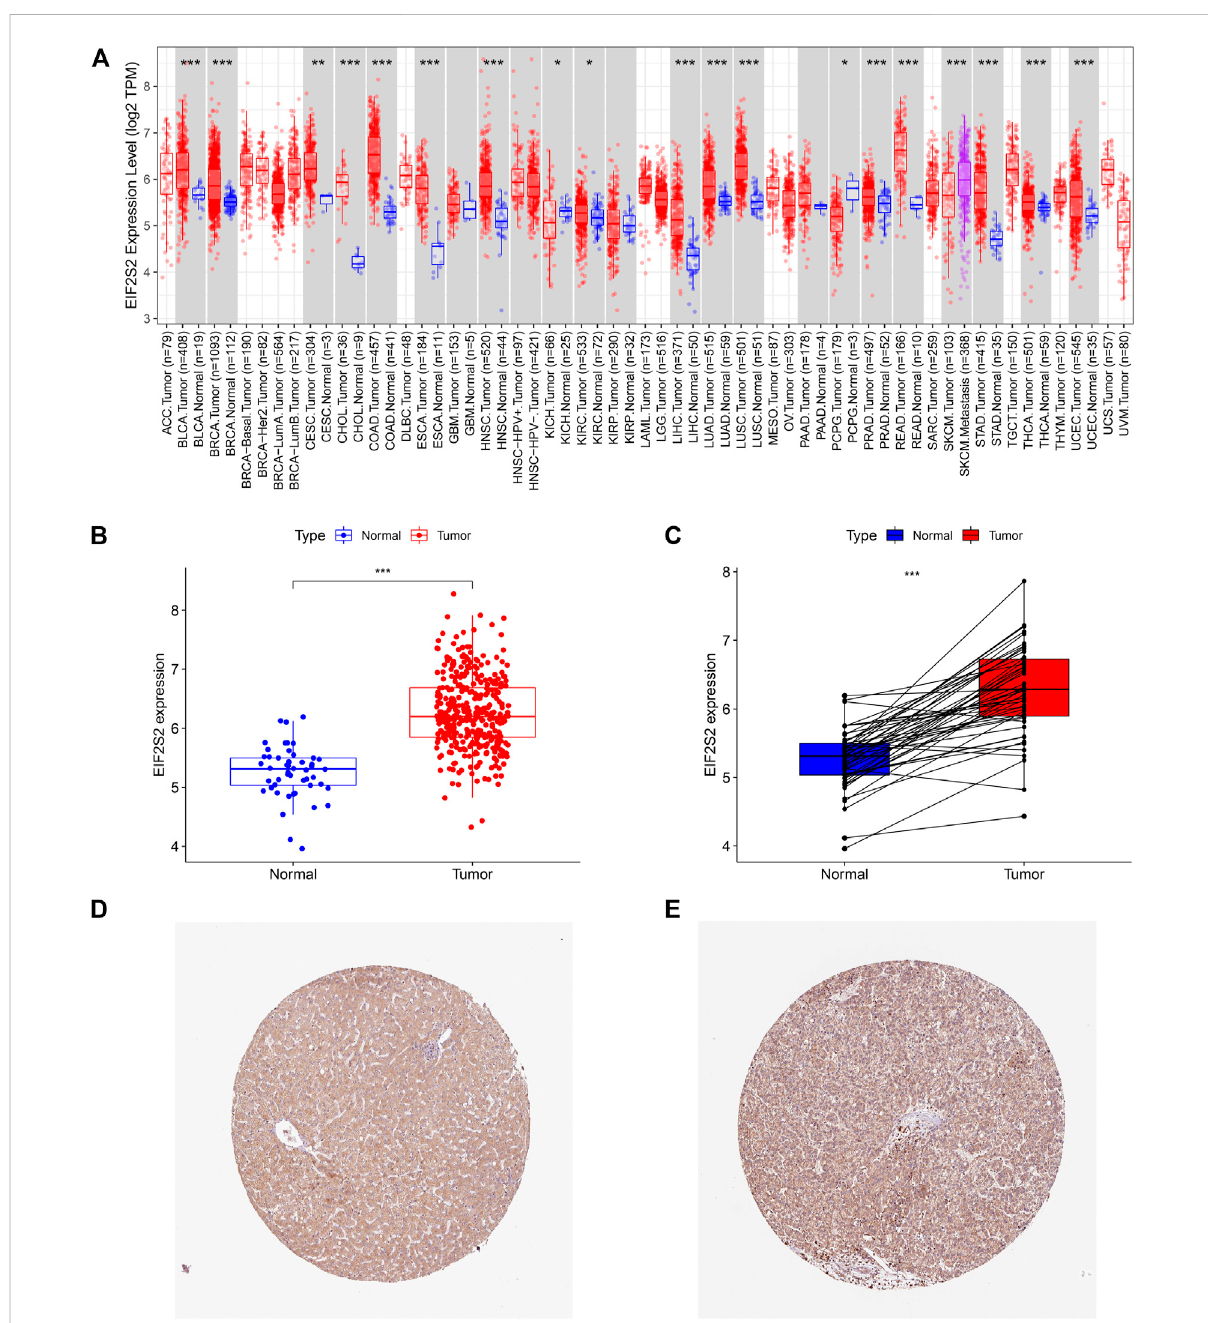
FIGURE 1 The expression of EIF2S2 in HCC. (A) EIF2S2 expression levels in different human tumor types according to TIMER 2.0 database. (B) EIF2S2 expression was compared in tumor tissue and control tissue samples in the TCGA database. (C) EIF2S2 expression levels were compared for pairedtumorandcontroltissuefromtheTCGAdatabase. (D,E) RepresentativeimmunohistochemicalimagesofEIF2S2proteinexpressioninnormal and hepatocellular carcinoma tissues. * p < 0.05, ** p < 0.01, *** p <